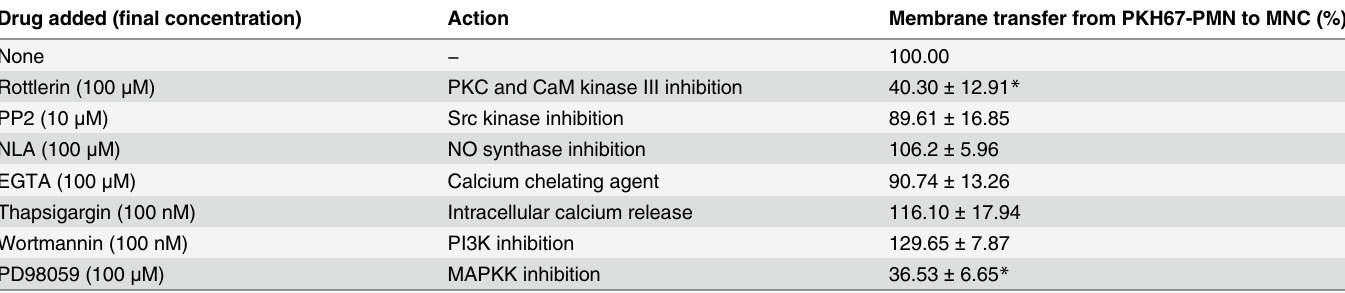
Table 4. Effects of different inhibitors on PMN-MNC trogocytosis detected by flow cytometry. Drug added ( fi nal